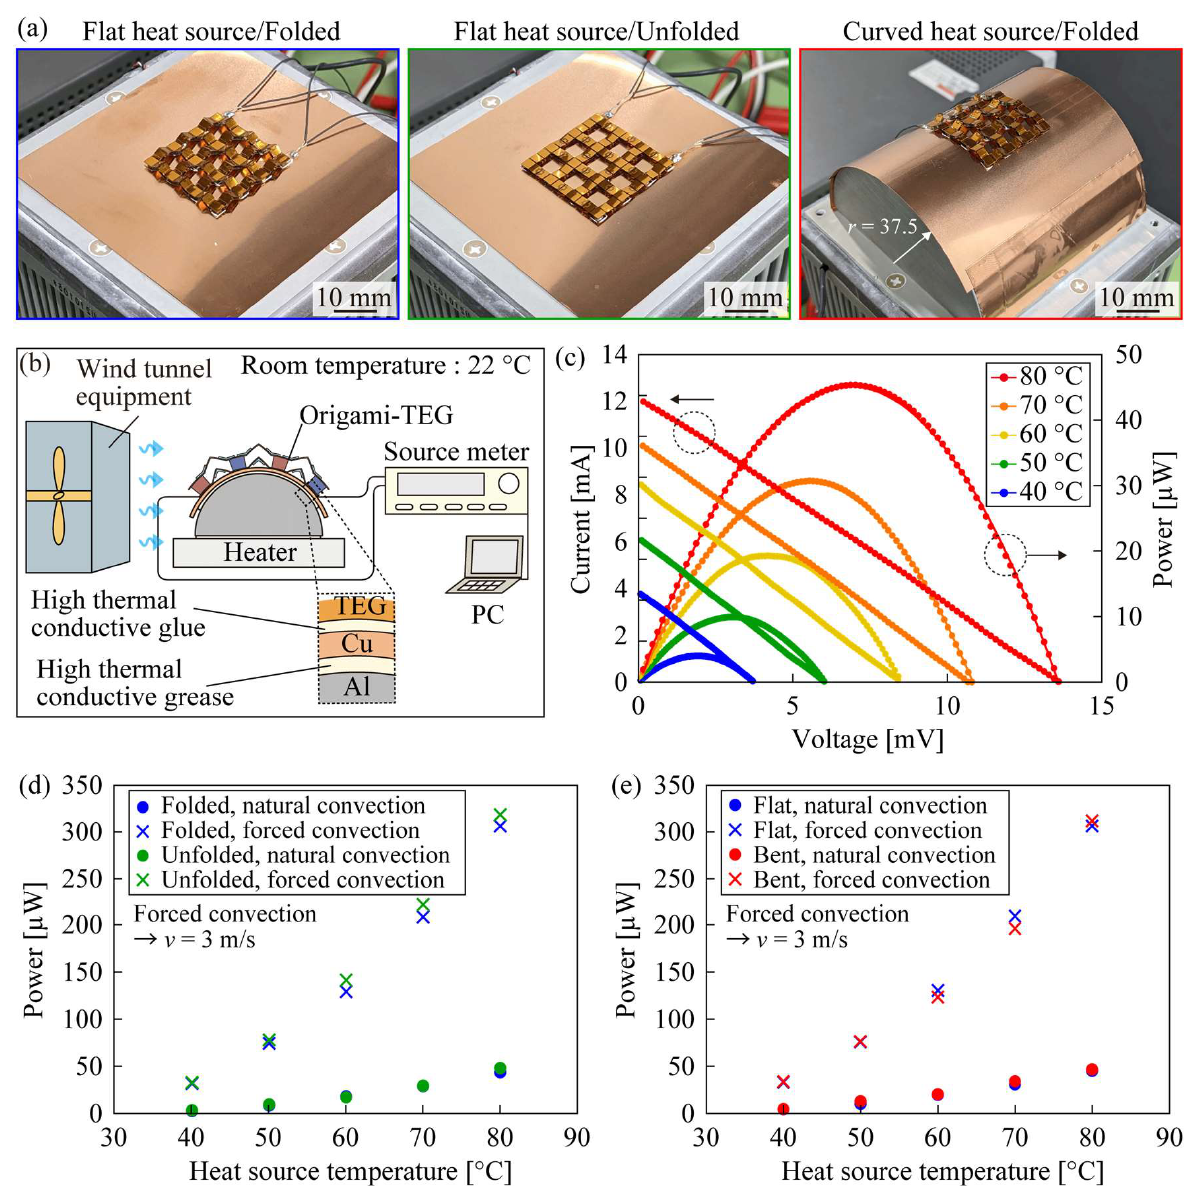
Figure 4. Performance evaluation of origami-TEG. ( a ) Photographs of three measured states of origami-TEG ( b ) Experimental setup during basic characteristics’ measurement. ( c ) Current-voltage and power-voltage characteristics of a folded origami-TEG when attached to a flat heat source. ( d ) Stability of output power against stretching deformation. ( e ) Stability of output power against bending deformation.